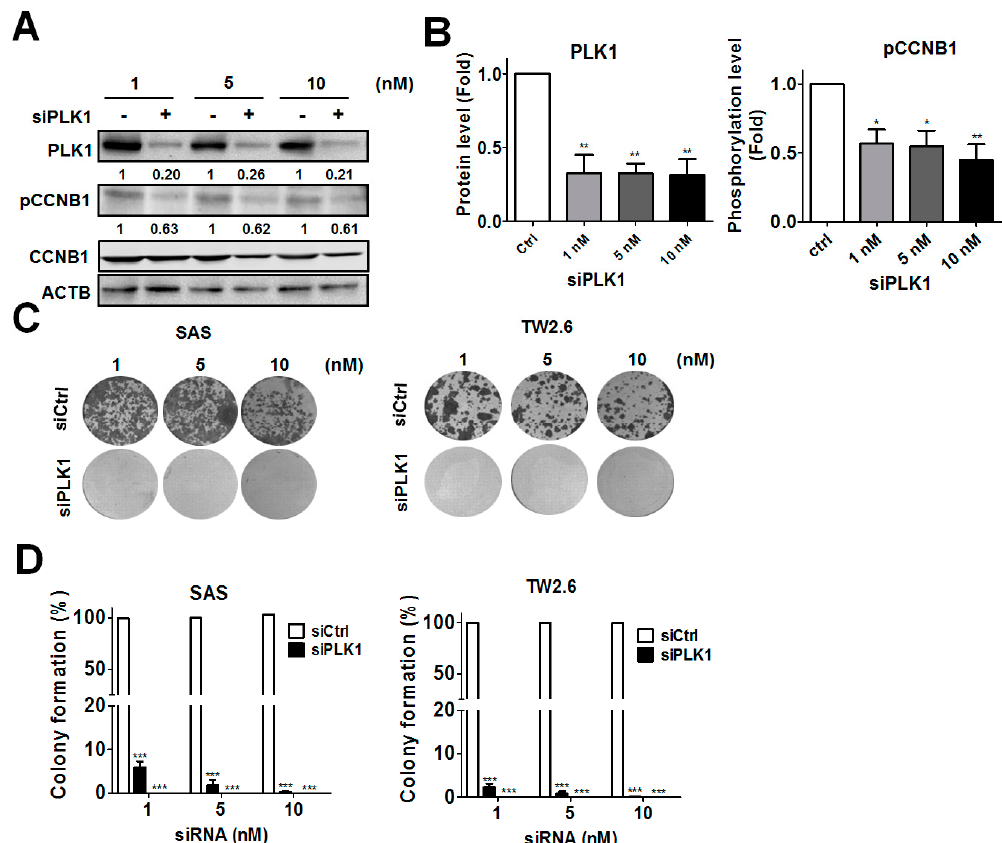
Figure 2. Effects of the siRNA (small interfering RNA) against PLK1 (polo-like kinase 1) on colony formation in OSCC (oral squamous cell carcinoma) cells. ( A ) Human oral cancer SAS cells were transfected with a siRNA (1, 5, and 10 nM) against PLK1 kinase for 48 h. The knockdown efficiency of PLK1 and the phosphorylation of its downstream protein, cyclin B1 (CCNB1), in the cells were examined by immunoblotting. ( B ) The quantitative results for (A) are expressed as the mean ± standard error of the mean (SEM) from three independent experiments. * p < 0.05, ** p < 0.01 vs. the non-targeting control siRNA (siCtrl). ( C ) SAS and TW2.6 cells were transfected with various concentrations of the siRNA against PLK1 and cultured for 14 days. The cells were fixed and stained with crystal violet to count the number of colonies formed. ( D ) The quantitative results for (C) are expressed as the mean ± SEM from three independent experiments. *** p < 0.001 vs. the non-targeting control siRNA (siCtrl).